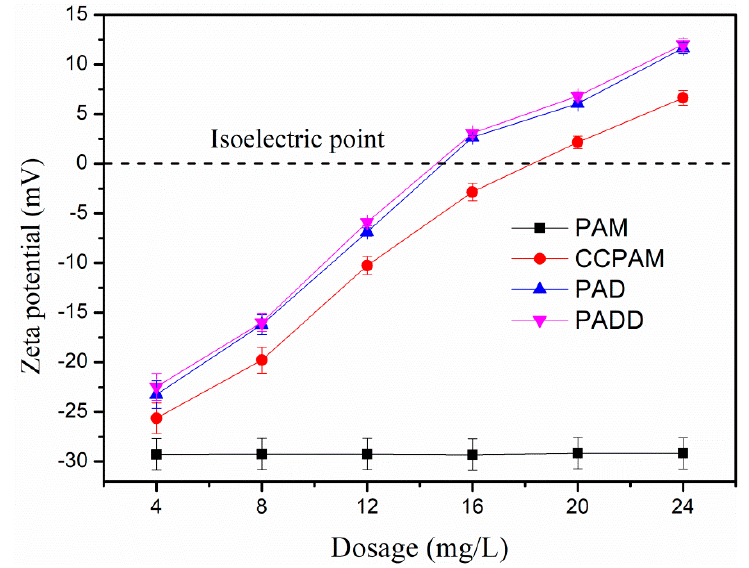
Figure 10. Zeta-potential for different flocculants.